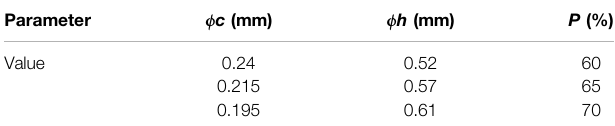
TABLE 3 | Optimized structural parameters of the porous